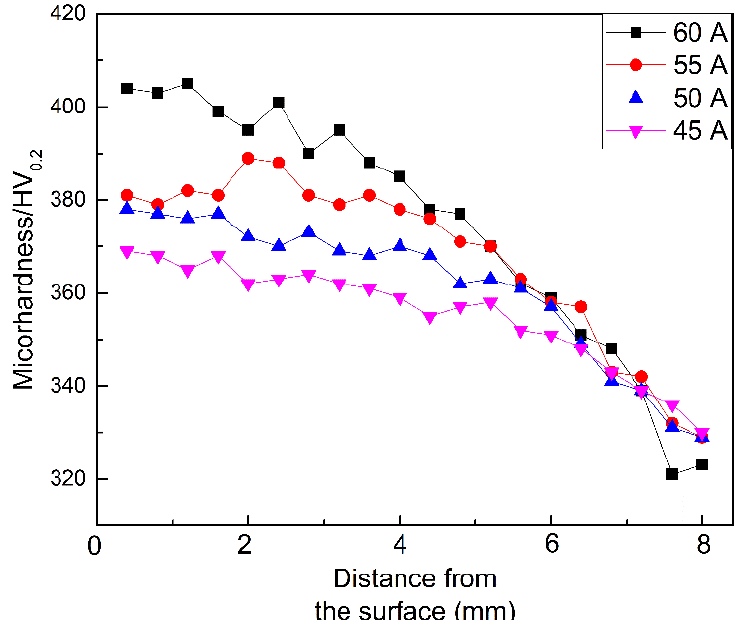
Figure 9. Microhardness of the iron-based alloy coatings.